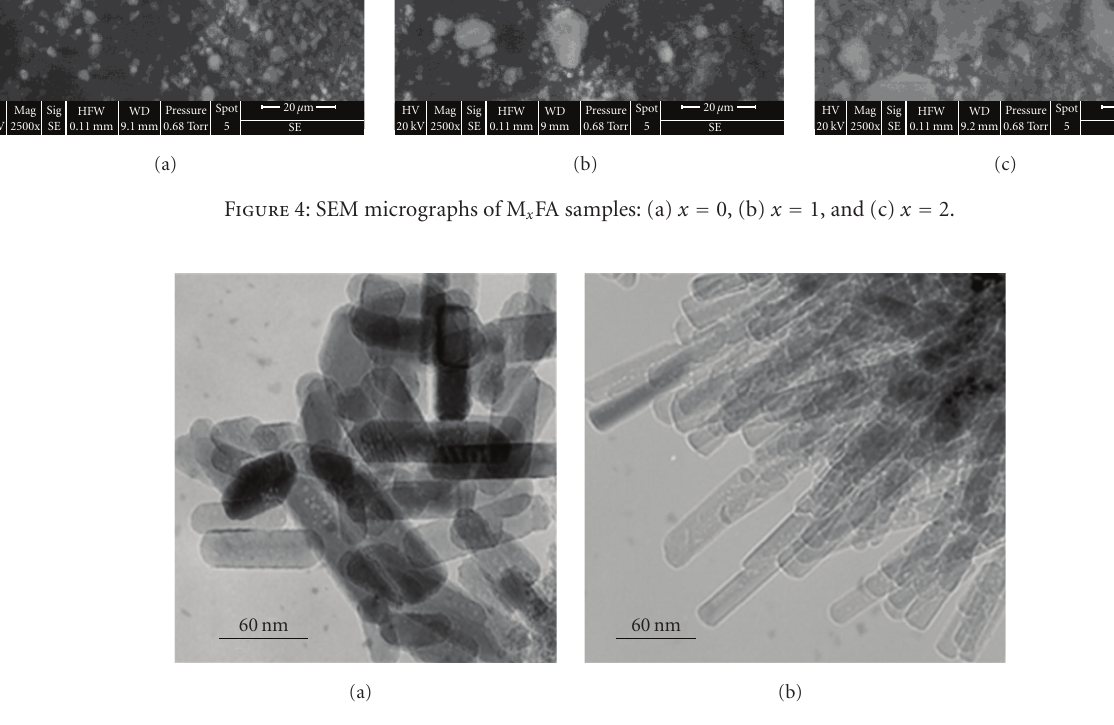
Figure 5: TEM micrographs of M x FA samples: (a) x = 0 and (b) x = 1.